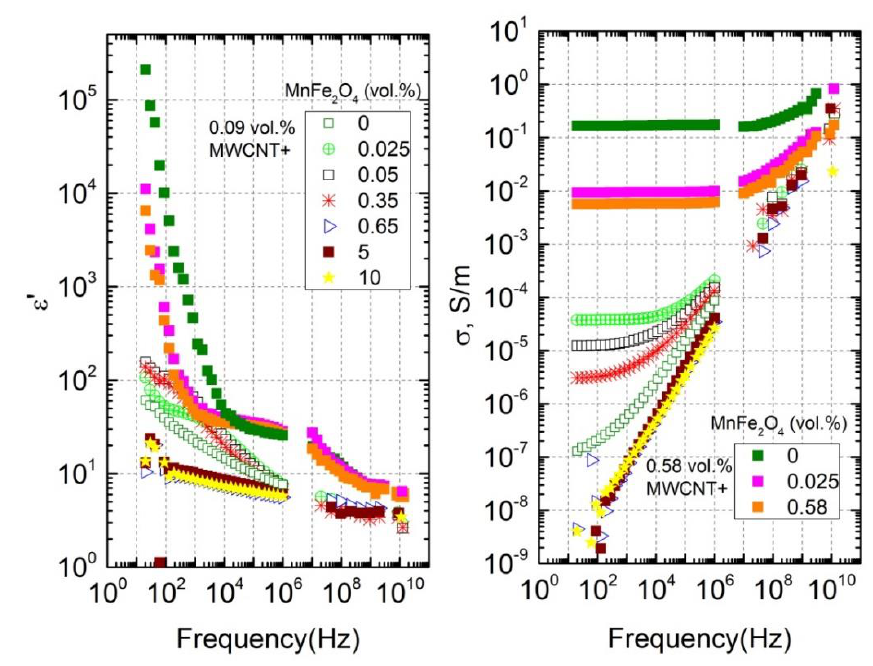
Figure3. Frequencydependenciesoftherealpartofdielectricpermittivityandtheelectricalconductivity Figure 3. Frequency dependencies of the real part of dielectric permittivity and the electrical for all composites under study at room conductivity for all composites under study at room temperature.